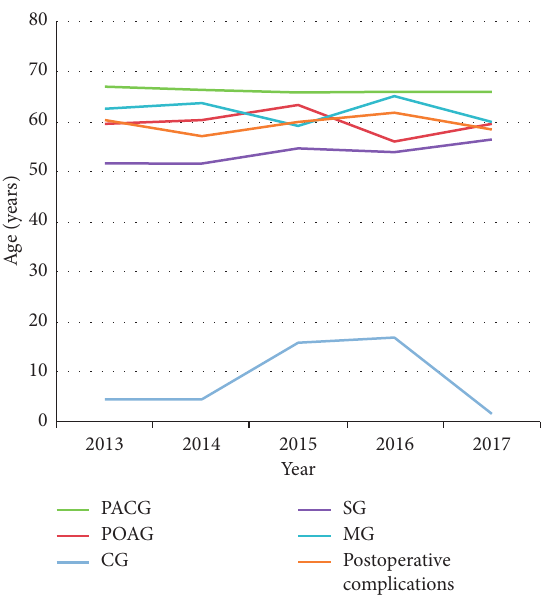
Figure 1: The trend of average age of glaucoma patients from 2013 to 2017 (years). PACG � primary angle-closure glaucoma, POAG � primary open-angle glaucoma, SG � secondary glaucoma, MG � mixed glaucoma, and CG � congenital